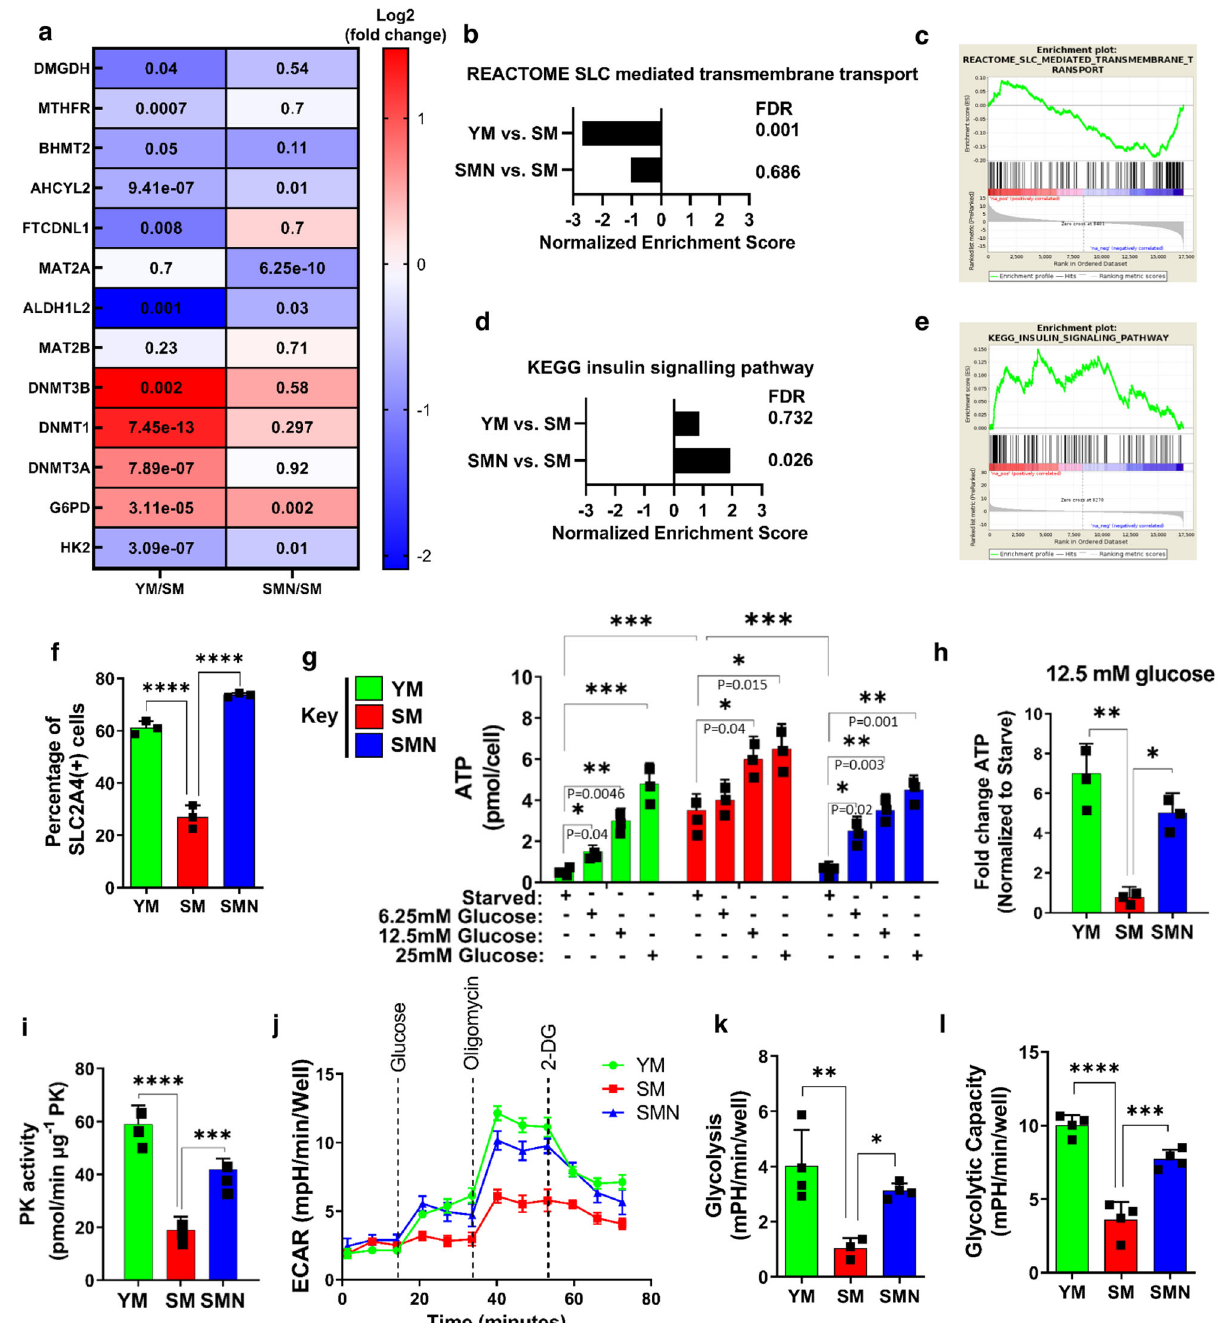
Fig. 1 | Impaired glycolytic capacity in senescent human myoblasts is restored upon NANOG expression. a Heat map of representative metabolic enzymes in RNA-seq with signi fi cant difference between YM and SM (YM/SM) or SMN and SM (SMN/SM). b – e GSEA analysis showing changes in SLC transporter expression and insulin signaling pathways. f Flow cytometry analysis of YM, SM, and SMN stained with APC-conjugated Glut4 antibody shows the percentage of SLC2A4+cells. (**** p <0.0001)statisticalsigni fi canceusingone-wayANOVAwithTukey ’ smultiple comparisons test. g Intracellular ATP level was measured after short-term starva- tion of cells for 6h followed by treatment with the indicated glucose concentra- tions (6.25, 12.5, and 25mM). (*** p <0.001) statistical signi fi cance using two-way